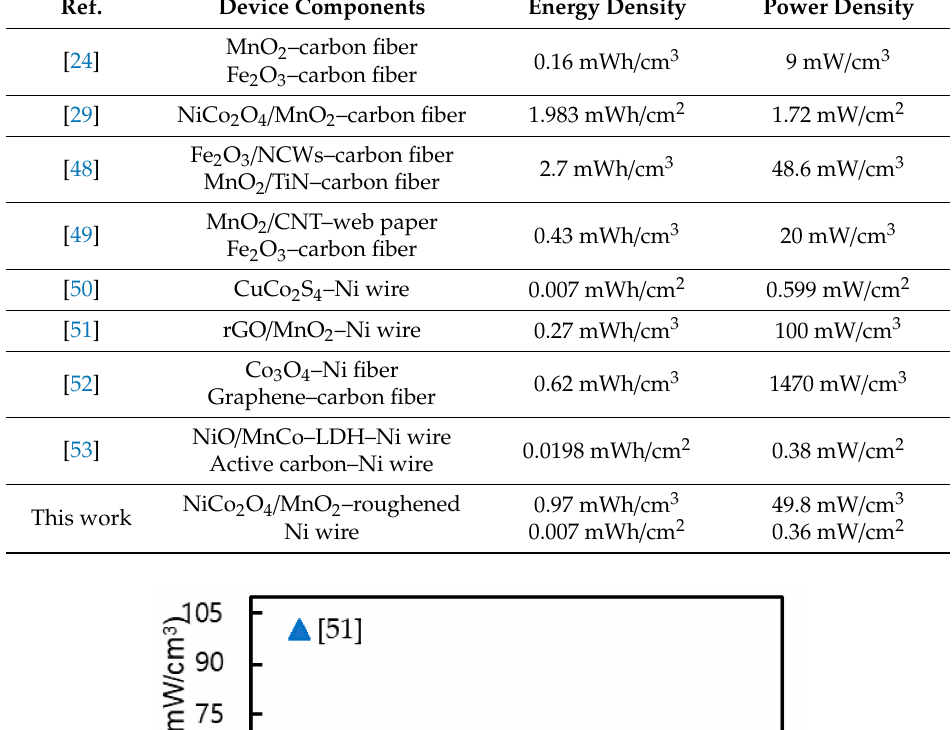
Table 1. Comparison of energy density and power density of supercapacitors in recent publications. Ref.